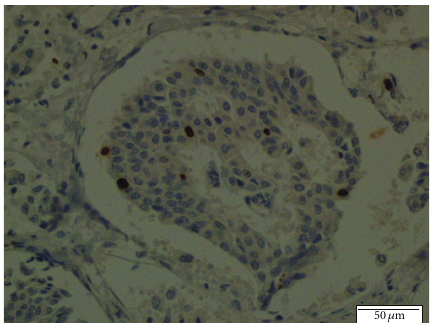
Figure 5: Microscopic appearance of tumoral lesion in the resected liver specimen at higher magnification. H.E. × 400.